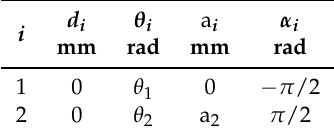
Table 1. Denavit–Hartenberg parameters of the